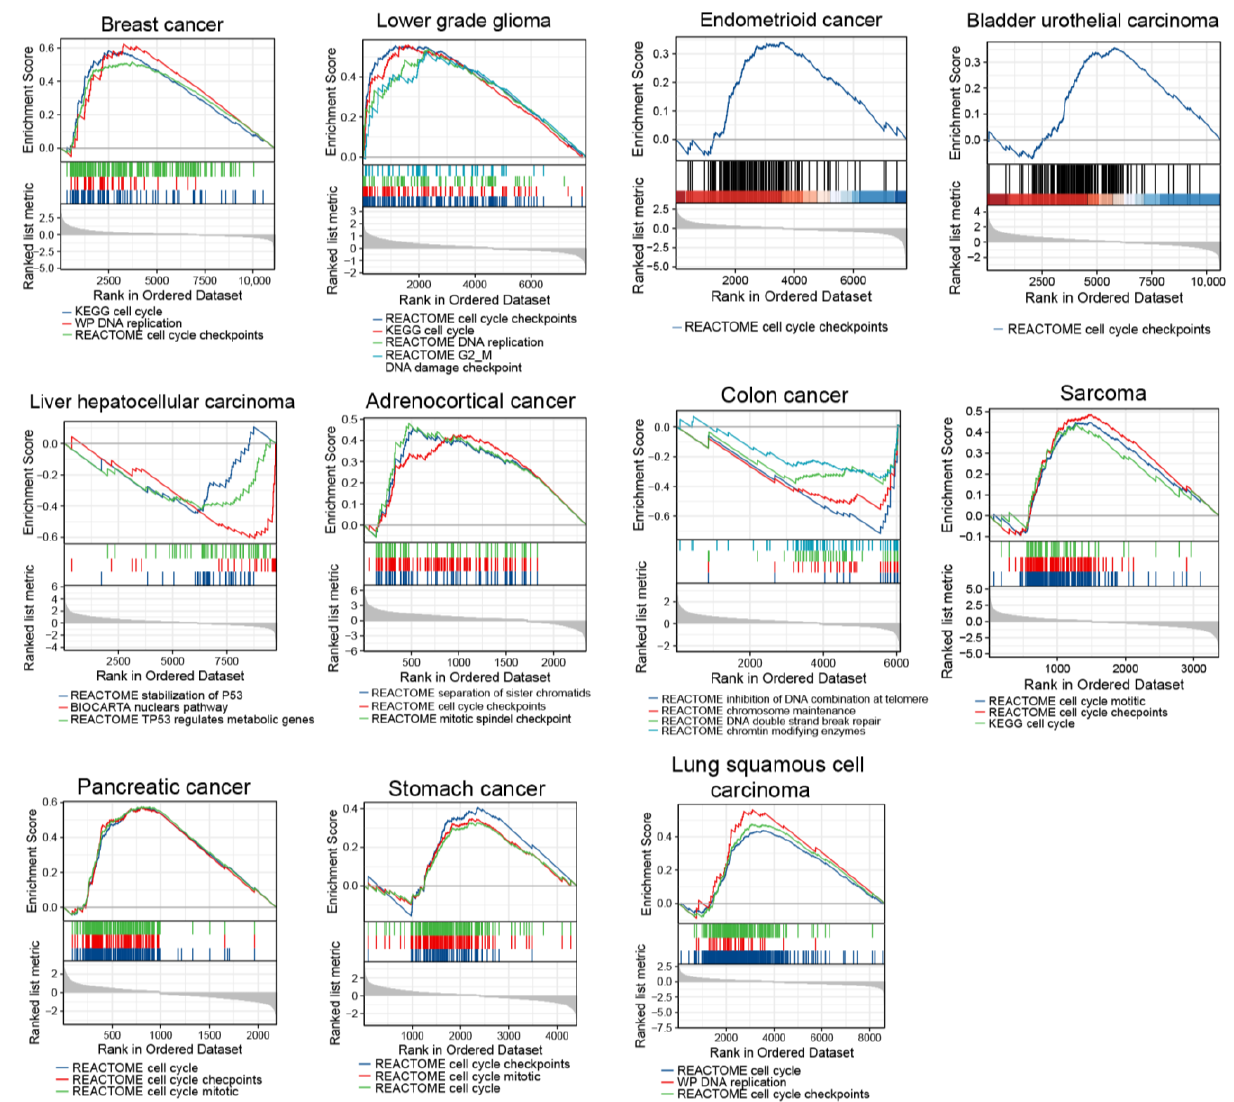
Figure 5. GSEA results are shown for upregulated pathways involved in cell cycle and DNA replication as well as inhibited pathways involved in stabilization of P53 and chromosomal maintenance.